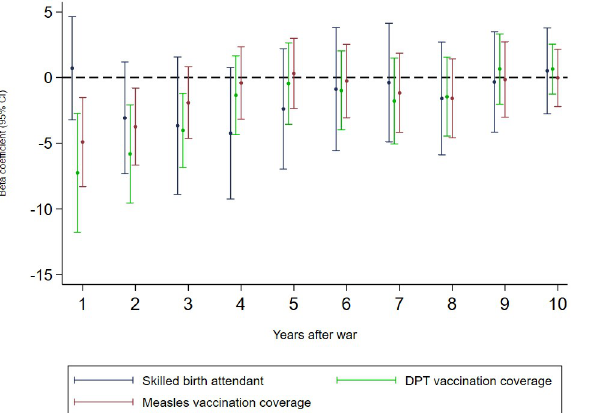
Fig 2. The AU : InFig 2 : thewordattendantismisspelled : Pleasefix : association between war and delivery by a skilled birth attendant and childhood vaccinations with up to 10-year lags. Each line represents the output from a fixed effects panel regression model adjusted for 10 covariates and year fixed effects, showing the war coefficient only. DPT, diphtheria, pertussis, and tetanus.